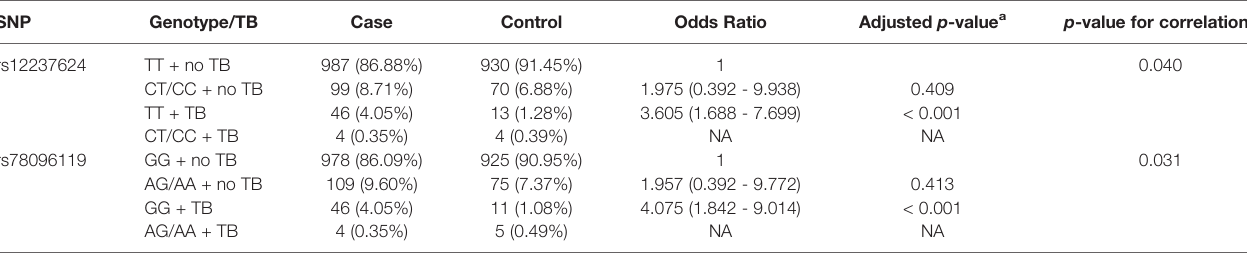
TABLE 3 | Correlation between PDCD1LG2 SNPs and pulmonary TB for lung adenocarcinoma susceptibility.